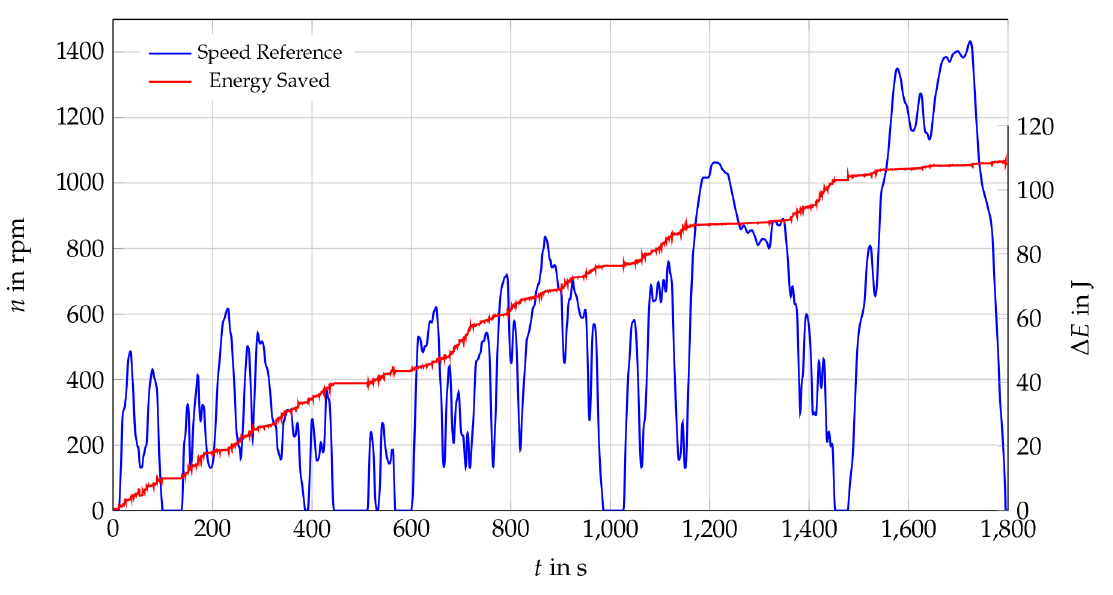
Figure 19. Simulation of saved energy using the template adaptation algorithm with the WLTP